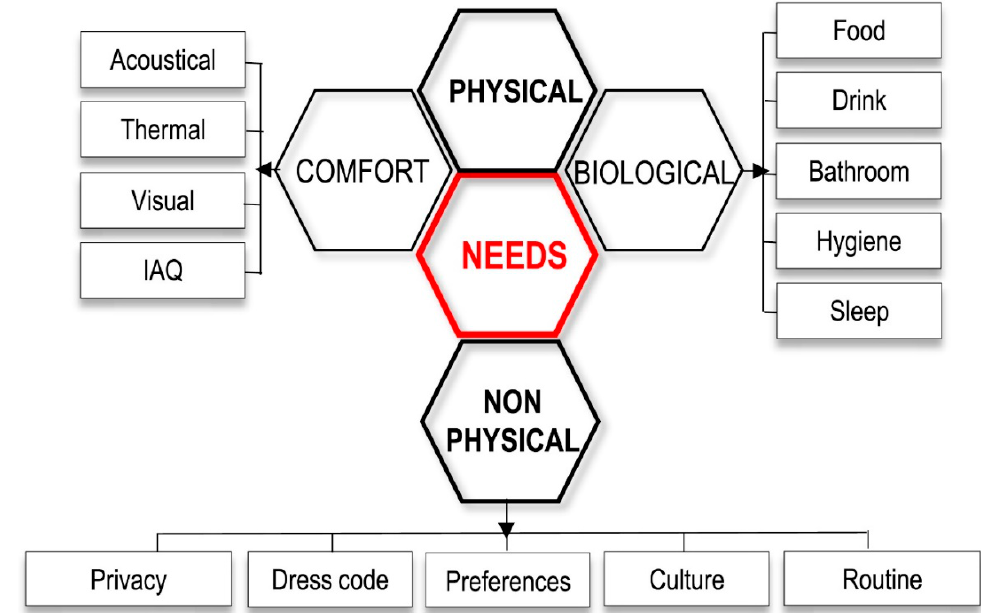
Figure 13. Needs of occupants that can impact the building energy use [112] (Reprinted from Elsevier